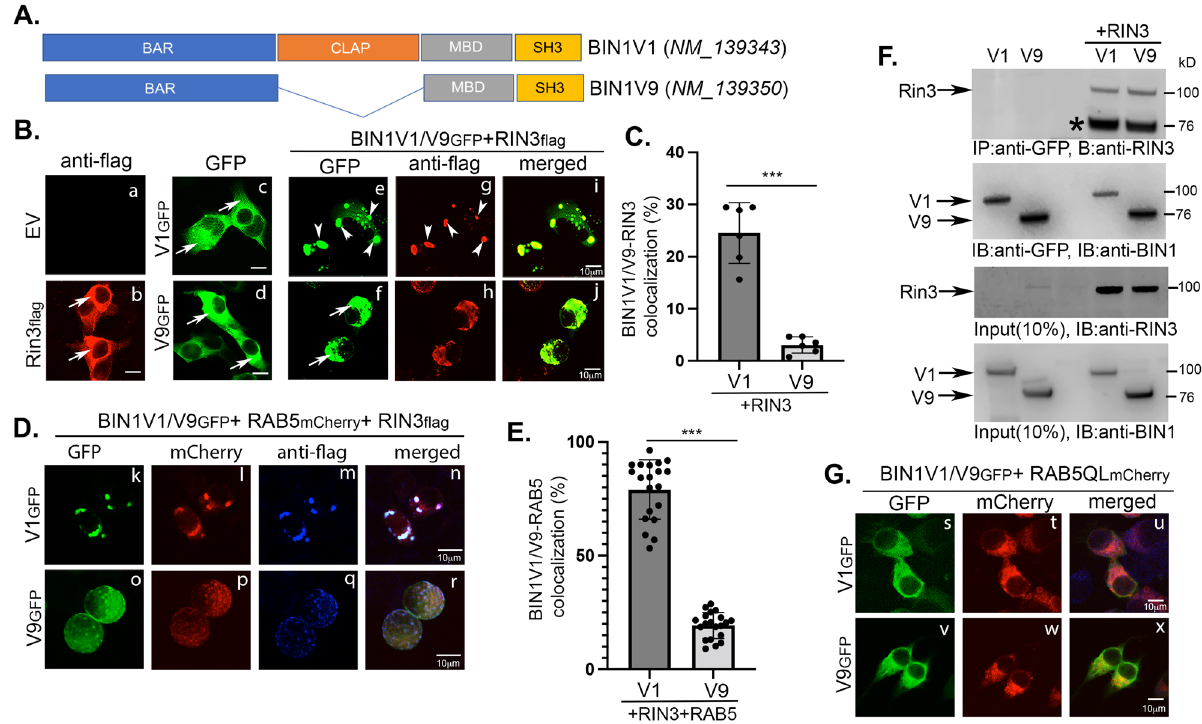
Figure 1. The neuronal isoform BIN1V1, but not non-neuronal BIN1V9 translocates to RAB5-positive early endosomes in a RIN3-dependent manner. ( A ) Schematics of neuronal BIN1V1 and non-neuronal BIN1V9 proteins. BAR (Bin-Amphiphysin-Rvs), CLAP (clathrin and AP-2-binding), MBD (Myc-binding domain) and SH3 (Src homology domain 3) domains are indicated. BIN1V1 contains the CLAP domain, while BIN1V9 does not. ( B ) Confocal microscopy of neuro 2A cells expressing control empty vector (EV, a), flag-epitope tagged RIN3 (RIN3 flag , a), BIN1V1 GFP (V1 GFP , c and e) or BIN1V9 GFP (V9 GFP , d and f) without (c and d) or with RIN3 flag (e-j). Cells were fixed and immunostained with anti-flag antibody to detect RIN3 flag (anti-flag) distribution. GFP-signals (GFP) detected subcellular distribution of GFP or BIN1V1/V9 GFP . Confocal microscopy shows predominant cytoplasmic distribution (arrows) of RIN3 flag , BIN1V1 GFP and BIN1V9 GFP , when expressing alone (b, c, and d, respectively). BIN1V1 GFP and RIN3 flag translocated to endocytic vesicles when co-expressed (arrowheads, e, and g). BIN1V9 GFP and RIN3 flag remained cytoplasmic even when expressed together (arrows, f, and h). Merged images (merged, i and j). ( C ) Analysis of BIN1V1 or BIN1V9 co-localization with RIN3, V1 + RIN3 or V9 + RIN3, respectively. 6 frames containing 5–10 cells were measured. *** p < 0.001. ( D ) Confocal microscopy of cells expressing BIN1V1 GFP or BIN1V9 GFP with RIN3 flag (anti-flag) and RAB5 mCherry (mCherry).